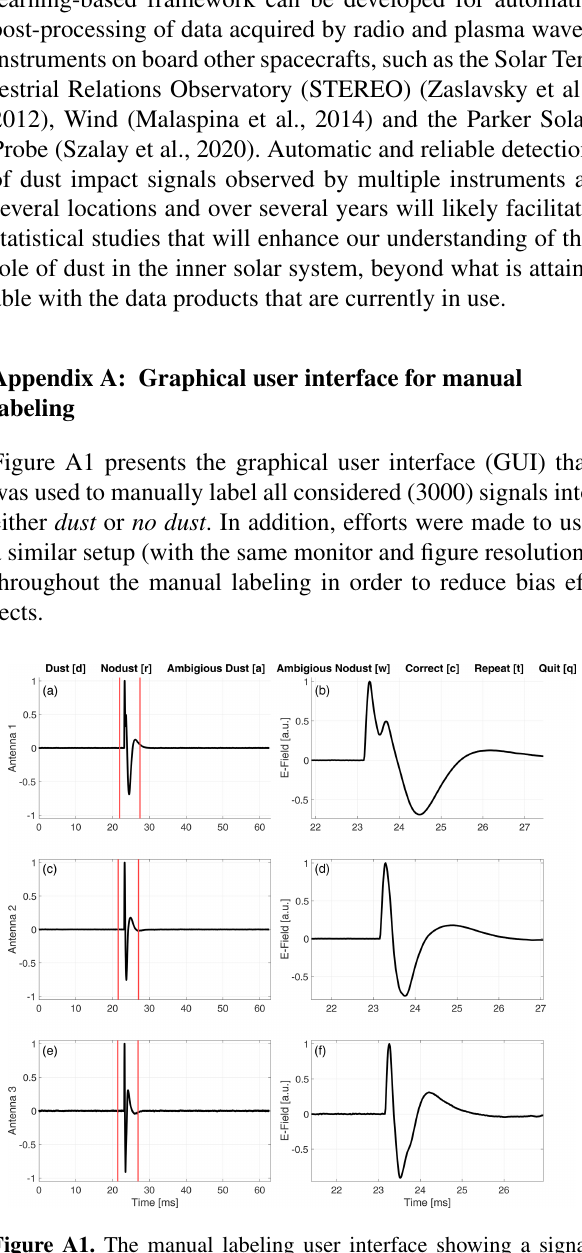
Figure A1. The manual labeling user interface showing a signal observed 28 July 2021. (a) , (c) and (e) display the full snapshot (from 0 to ∼ 63ms) at all antennas. An area of interest is selected by adjusting the red vertical lines. (b) , (d) and (f) display the signal within the area of interest. The signal can be labeled as dust by pressing the [ d ] key on the keyboard and no dust by pressing the [ r ] key. The signal is indicated to be ambiguous if the waveform does not fit clearly into either of the two labels; note however that signals indicated to be ambiguous were also labeled into either dust or no dust using the [ a ] and [ w ] keys. There is also an option to correct [ c ] the previously labeled signal (in case of an error), repeat [ t ] the area of interest selection and quit [ q ] the manual labeling user